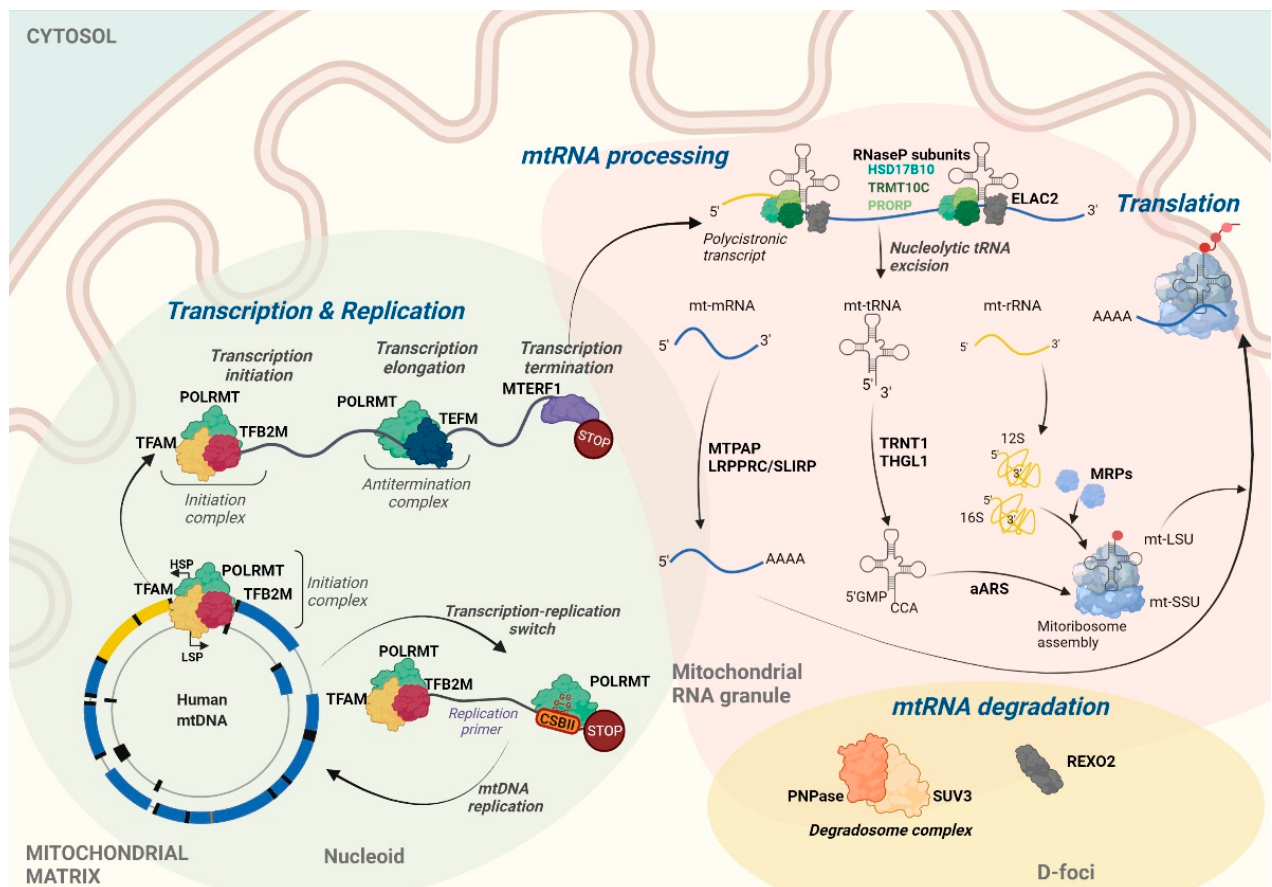
Figure 2. General overview of human mitochondrial gene expression. mtDNA replication and transcription occur within nucleoid structures (represented in light green) that spatially co-localize with mtRNA granules (MRGs, represented in light pink), which are suggested to be the place of post-transcriptional mtRNA processing and mitoribosome assembly. Degradation of mtRNA, mediated by the degradosome complex that involves SUV3 helicase and PNPase, occurs in D-foci that partially co-localize with MRGs. REXO2 exonuclease mediates the subsequent decay of RNA oligonucleotides. Aminoacyl-tRNA synthetases are abbreviated as aARS; mitochondrial ribosomal proteins are referred to as MRPs. Created with BioRender.com.